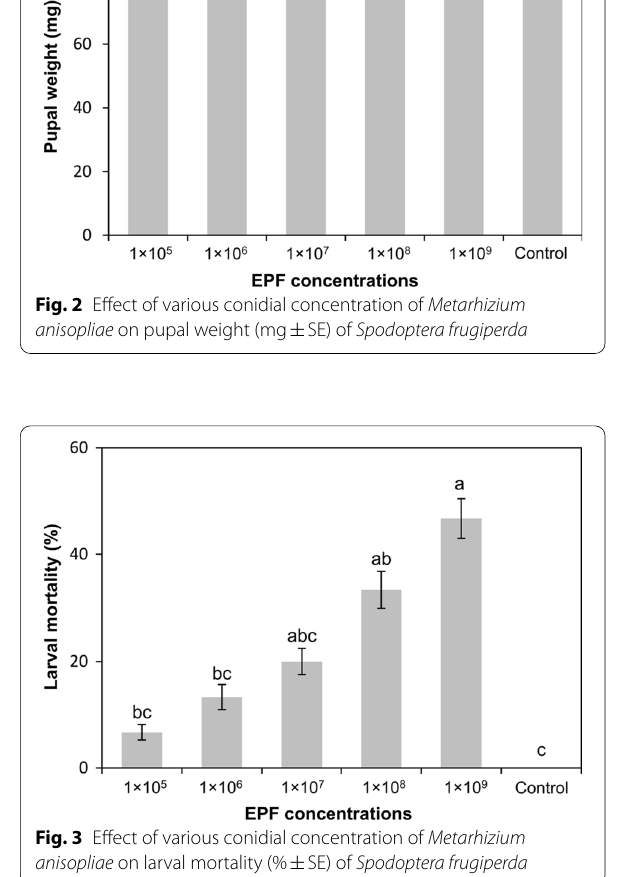
SE) of Spodoptera ±